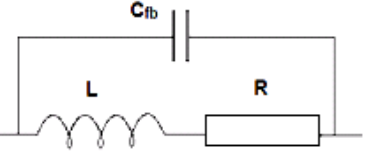
Figure 7: Series model of the integrated inductor with the coupling capacitance between windings.